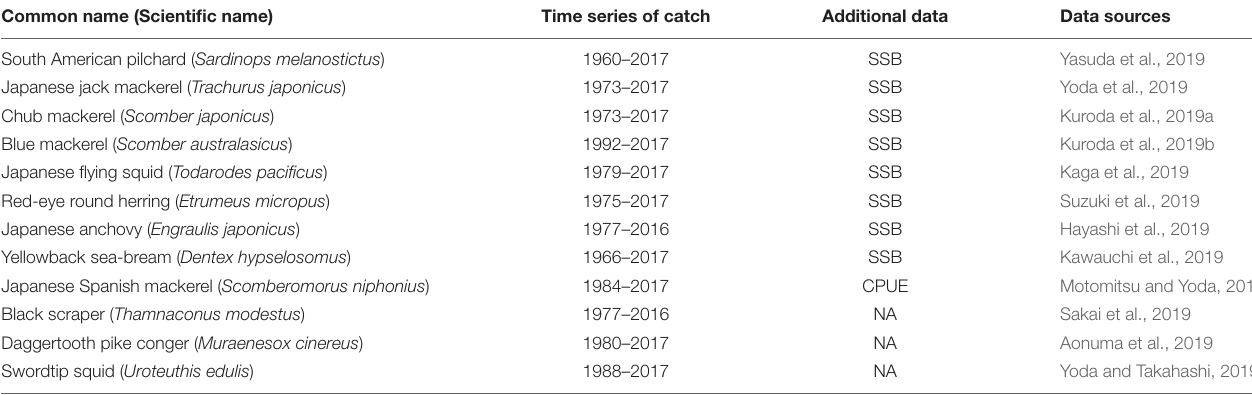
TABLE 1 | Basic information of the 12 fishery stocks in question.